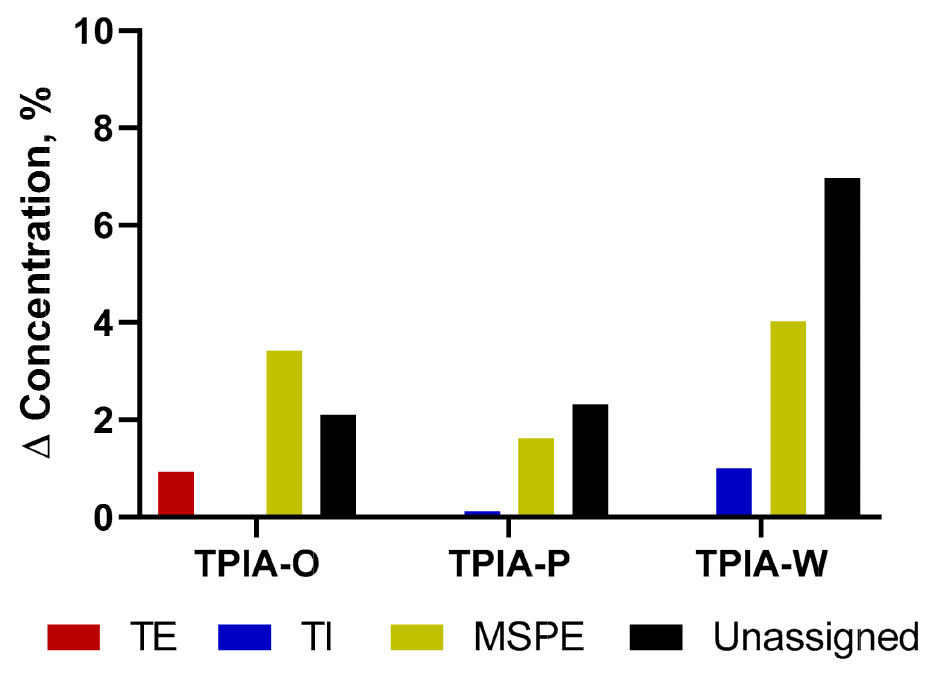
Figure 2. Treprostinil palmitil (TP) and DSPE-PEG2000 degradation products over three months of storage under accelerated conditions (40 ◦ C). TE = Treprostinil Ethyl, TI = Treprostinil Isopropyl, MSPE = 2-stearoyl-sn-glycero-3-phosphoethanolamine-N-[amino(polyethylene glycol)-2000], Unas- signed = Sum of all unidentified chromatogram peaks. Note that formation of TE is much greater for treprostinil palmitil inhalation aerosol (TPIA)-O than formation of TI is for